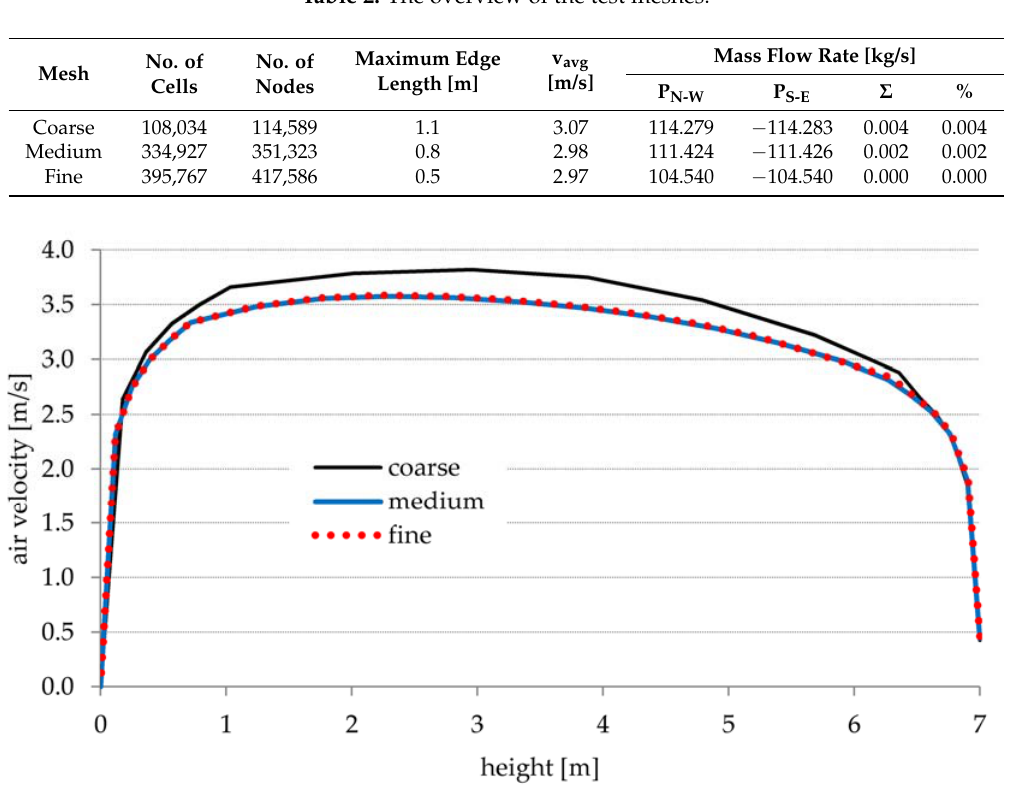
Table 3. Recorded weather conditions.